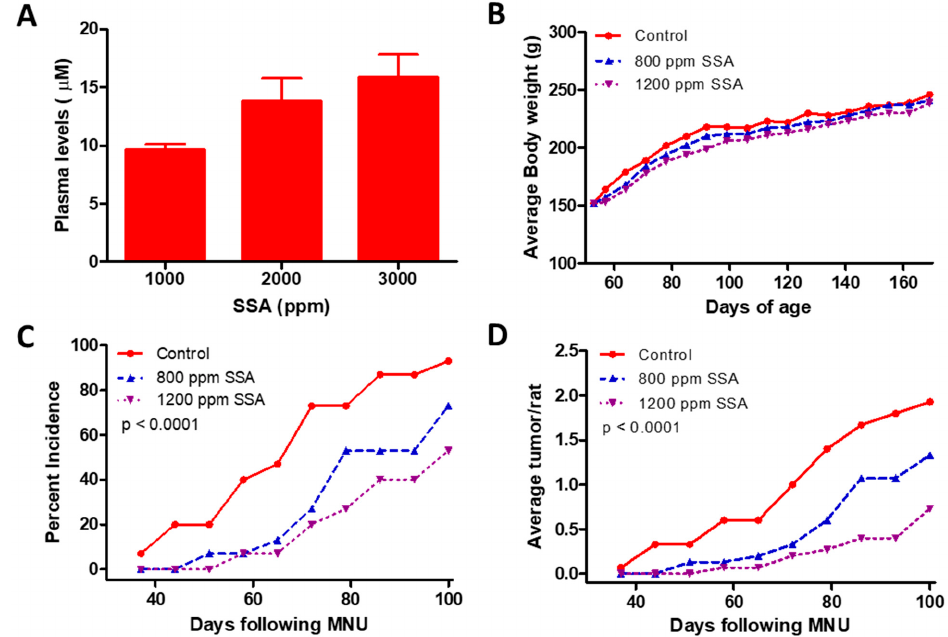
Figure 4. In vivo evaluation of the chemopreventive activity of SSA in MNU-induced rat model of mammary tumorigenesis. ( A ) Plasma levels of SSA achieved after feeding of SSA at various levels. ( B ) Effects of SSA feeding on body weight of Sprague-Dawley rats. ( C ) Tumor incidence and ( D ) tumor multiplicity in rats fed with vehicle control or SSA diet beginning 3 days after MNU exposure.